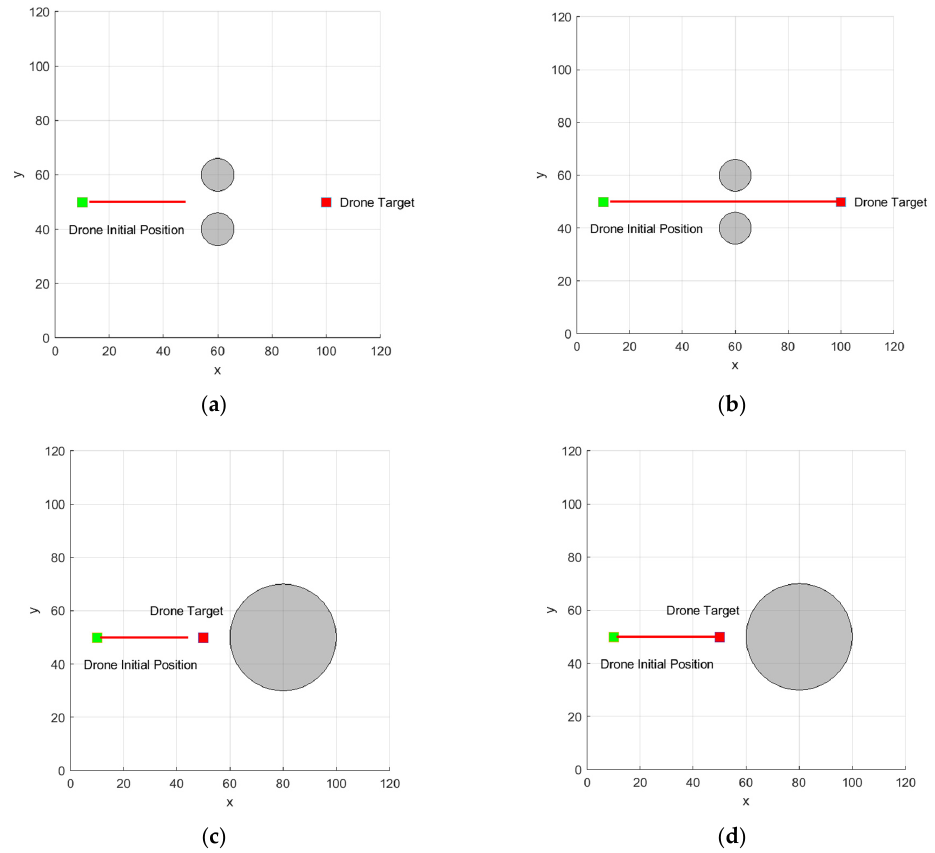
Figure 14. Escaping Local Optimal Solutions Using the 3D Bresenham’s Line Algorithm. ( a ) Tradi ‐ tional artificial ‐ potential ‐ field method. ( b ) Improved artificial ‐ potential ‐ field method. ( c ) Tradi ‐ tional artificial ‐ potential ‐ field method. ( d ) Improved artificial ‐ potential ‐ field method.